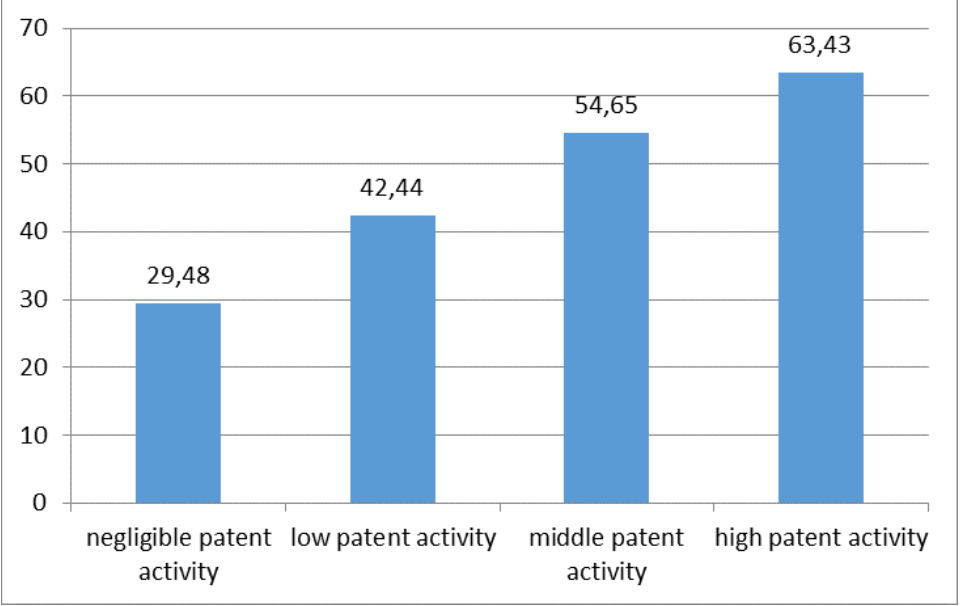
Figure 10: Average values of share of companies implementing EE-innovations by group of regions with differing patent activity